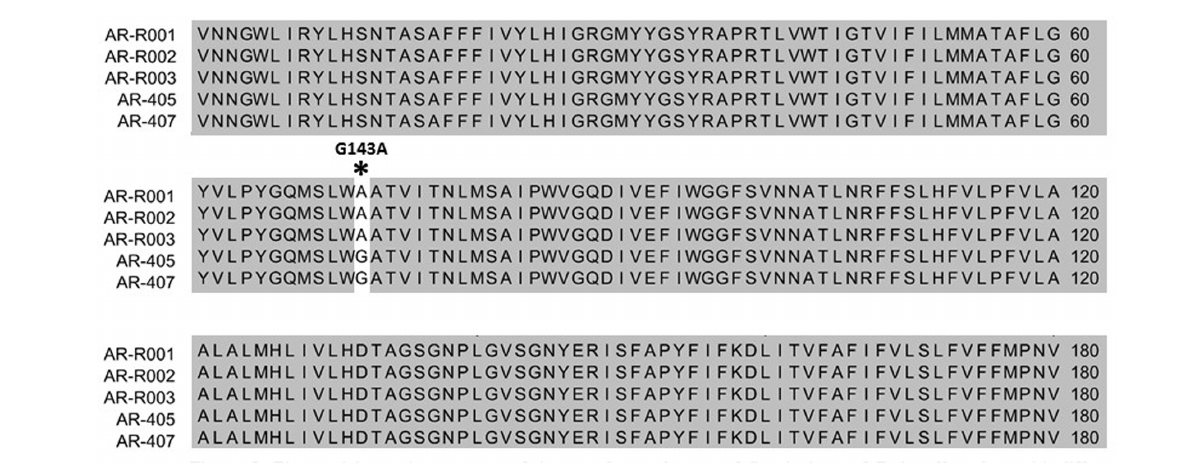
FIGURE 1 | The partial protein sequence of the cytochrome b gene of five isolates of Didymella rabiei with different Qol sensitivities. Star indicates the G143A amino acid substitution responsible for decreased sensitivity to Qol fungicides. Dark gray highlighted areas represent 100% identities.